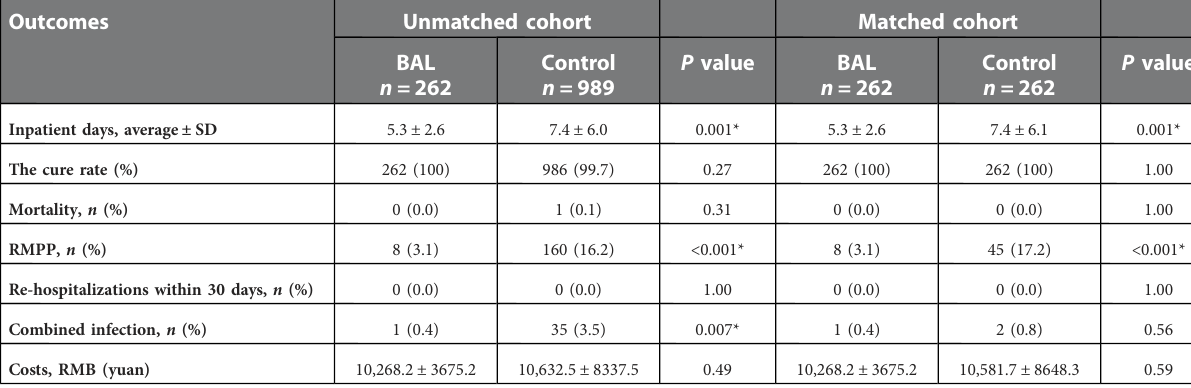
TABLE 2 Outcomes in the original unmatched cohort and matched